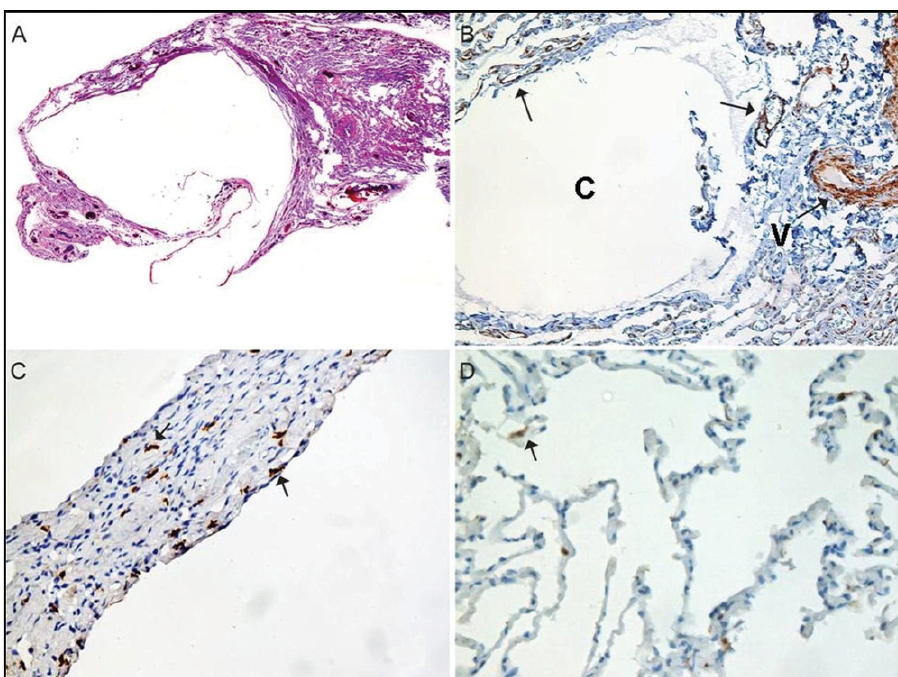
Figure 3 - Histopathological analysis of cystic lung lesions. A ) A large subpleural cyst within the lung parenchyma. The cyst formed by the collapse of the alveolar walls with a connective tissue lining (H&E staining; 40x magnification). B ) Details of a smaller cyst stained with an anti-alpha smooth muscle actin antibody. There are no positive LAM cells in the cyst wall. Adjacent blood vessel walls express actin. V=vessel, C=cyst (400x magnification). C ) Details of a subpleural cyst wall with a large number of MMP-9-positive cells, mostly macrophages and neutrophils, in the cyst wall (400x magnification). D ) Normal lung parenchyma adjacent to the cyst wall, showing scattered MMP-9-positive cells (arrow) in the alveolar walls